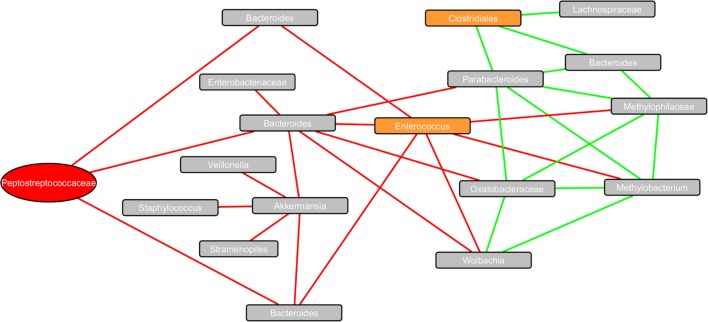
Co-occurrence network plot of bacterial taxa within the fecal microbiome of CDI patients. The co-occurrence network plot generated within the Cytoscape plugin Conet reveals strong positive (Spearman’s rho > 0.8) and strong negative (Spearman’s rho < -0.8) correlations between OTUs identified within 13 CDI stool samples. Eighteen unique OTUs (indicated by rectangular nodes) possessing strong correlations with one another are shown. The 16S rRNA sequence of the Peptostreptococcaceae node highlighted in red matched Clostridium difficile strain 630 (query cover = 100%) when BLAST searched. Additional potential pathogenic OTUs are shown in orange, including Enterococcus and an unclassified Clostridiales. Edges connecting nodes highlighted in green are indicative of a strong positive correlation, whereas edges highlighted in red are indicative of a strong negative correlation.